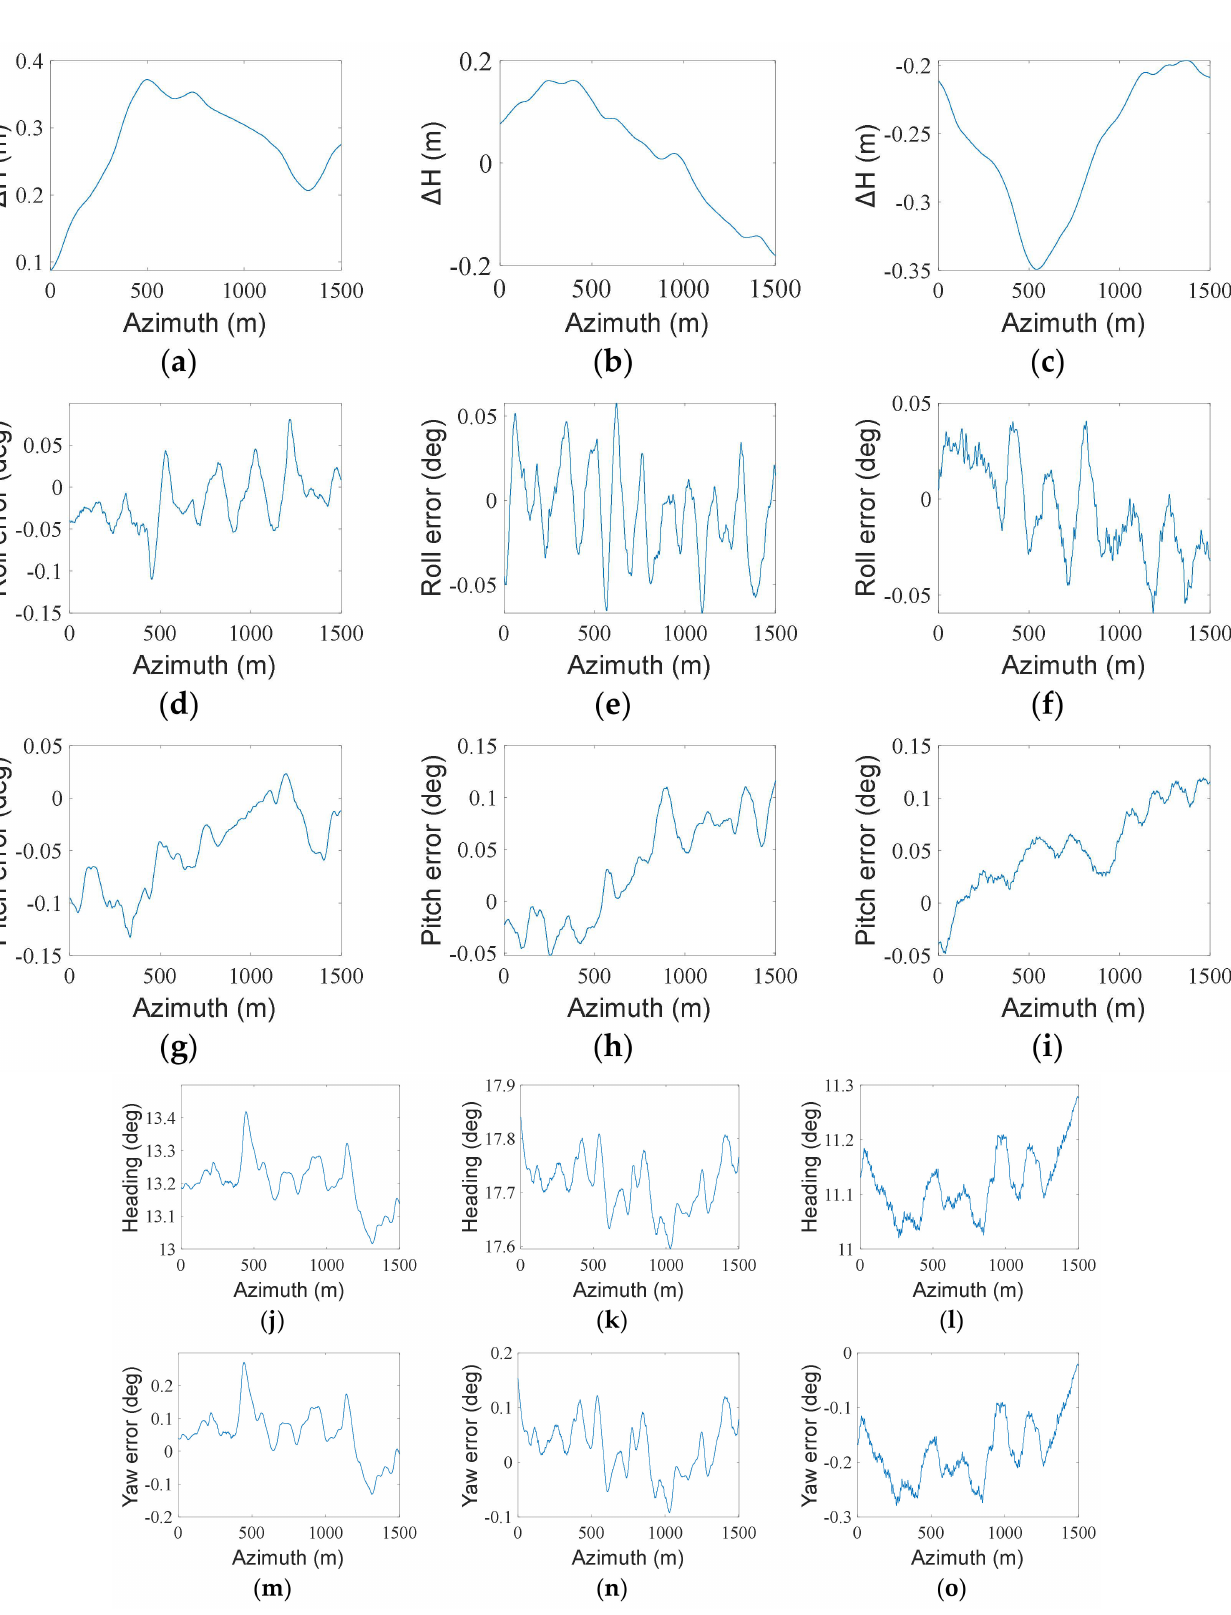
Figure 7. Attitude paraments of three data sets. ( a , d , g , j , m ) Platform altitude error, roll error, pitch error, heading angle, and yaw error of data RZ14. ( b , e , h , k , n ) Platform altitude error, roll error, pitch error, heading angle, and yaw error of data RZ16. ( c , f , i , l , o ) Platform altitude error, roll error, pitch error, heading angle, and yaw error of data